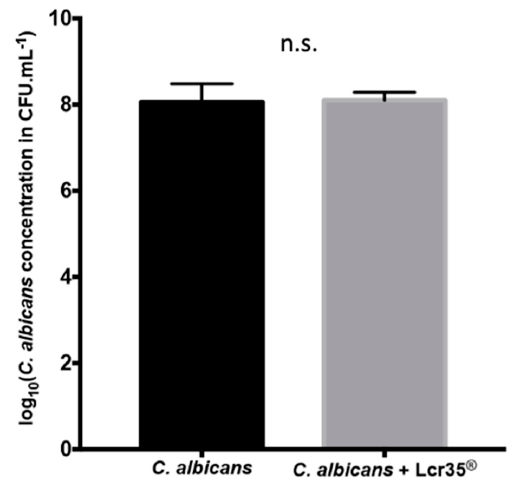
Figure 2. Determination of C. albicans concentration present in the biofilm in presence of Lcr35 ® or not onto Caco-2 cells monolayers (mean ± standard deviation). The amount of yeast present in the biofilm was evaluated after 48 h of incubation. Comparison between conditions with and without Lcr35 ® was performed using an unpaired t test (n.s.: not